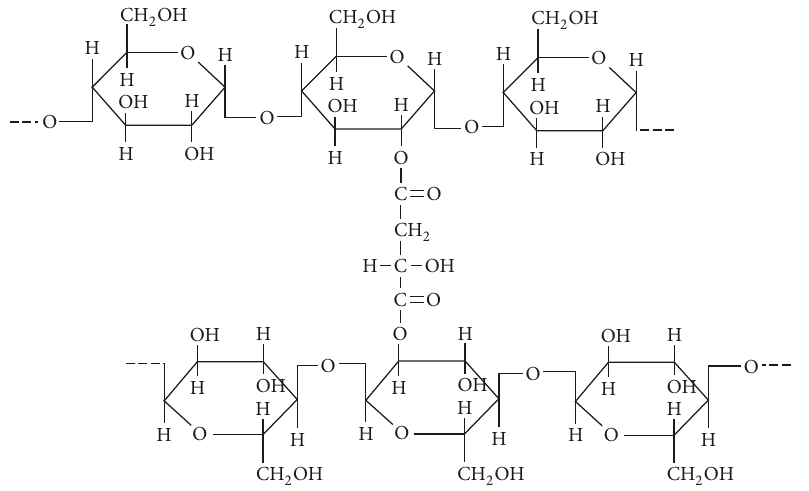
Figure 2: Structural formula of potato starch modification product.